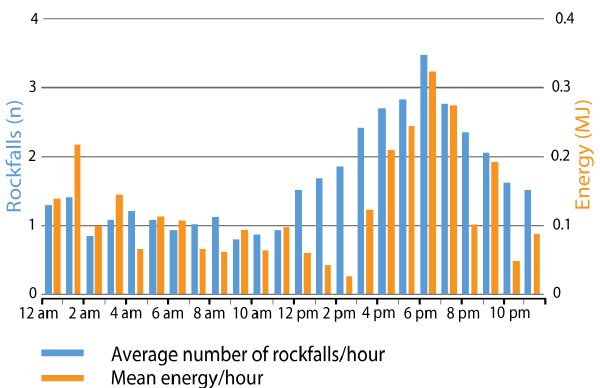
Figure 5. Evolution over 24h of (i) the average number of rockfalls per hour and (ii) the mean energy of a rockfall per